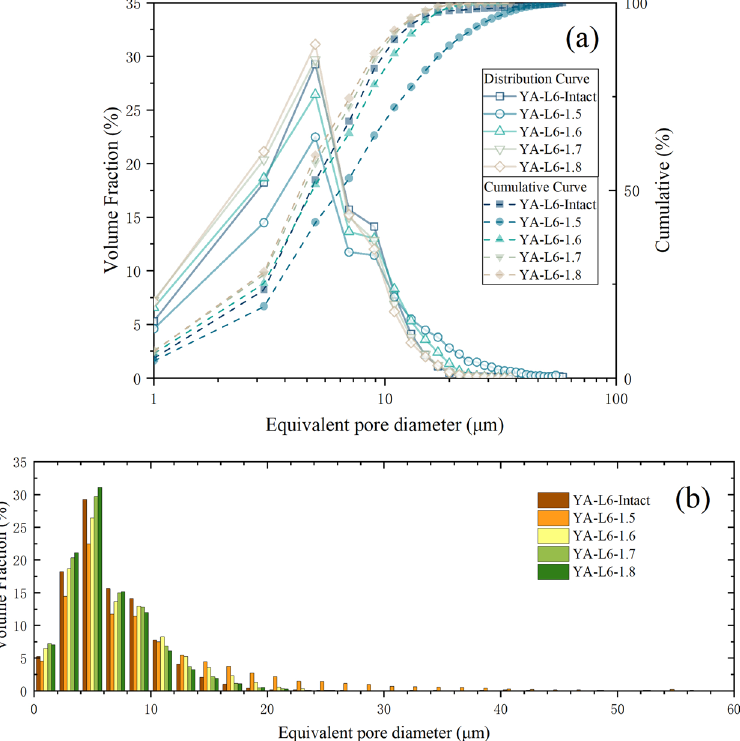
Figure 1. PSD of the five samples obtained from CT scanning: (a) line chart; (b) column